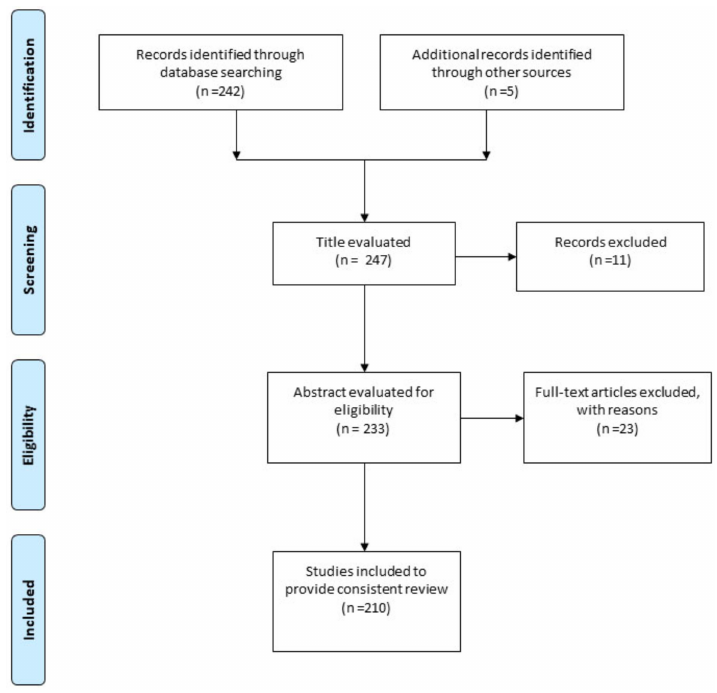
Figure 1. PRISMA flow diagram, showing the process of study